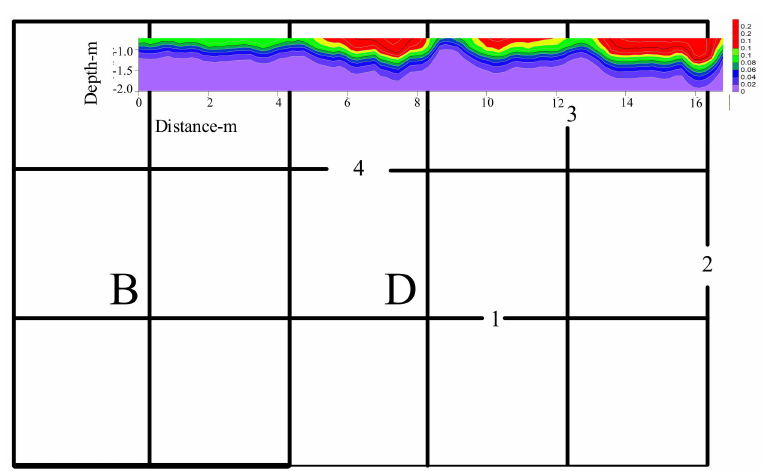
Figure 5. Apparent resistivity section with